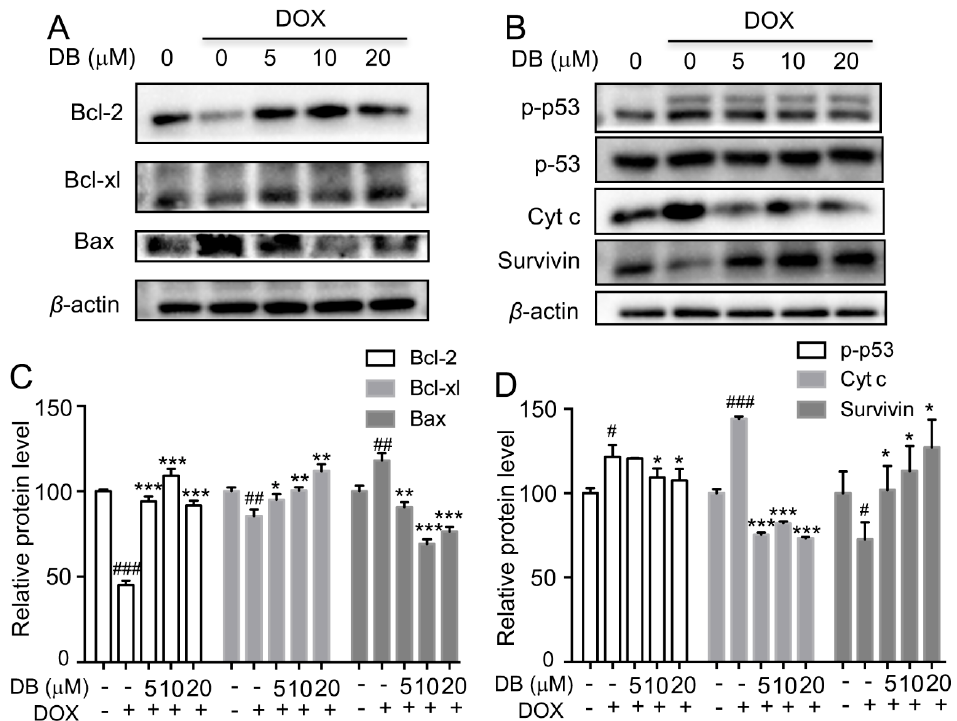
Figure 3. The preventive effect of DB on DOX-modulated Bcl-2 expression. ( A ) DB regulated the protein levels of Bcl-2, Bcl-xl and Bax induced by DOX; ( B ) DB mediated the expression levels of DOX-induced p53, Cyt c and survivin. Cells were pre-treated with DB for 2 h and then co-treated with DOX for 24 h, and the protein level were assessed by using Western blot analysis; ( C , D ) Semi-quantitative analysis of protein level. Beta-actin ( β -actin) served as the loading control. # p < 0.05, ## p < 0.01, ### p < 0.001 versus control and * p < 0.05, ** p < 0.01, *** p < 0.001 versus DOX.